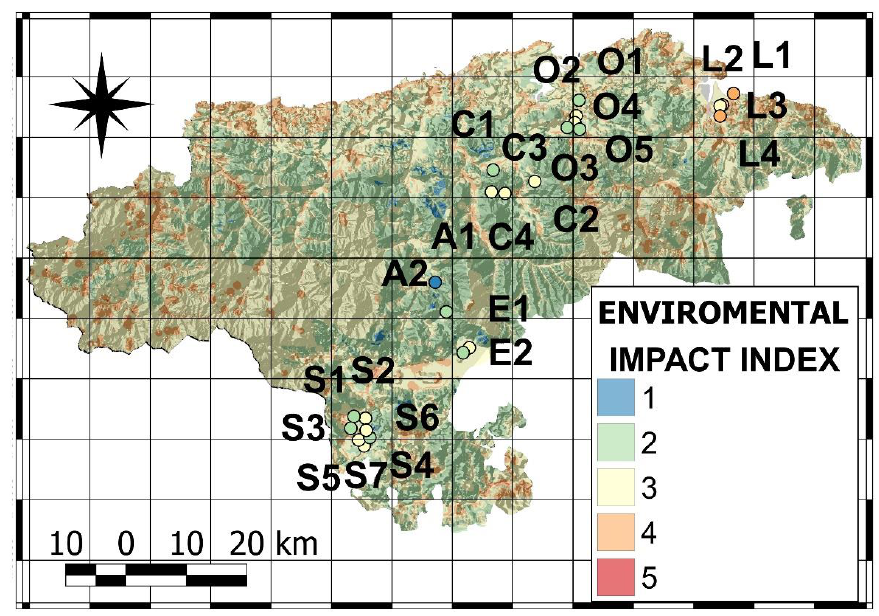
Figure 5. Map of reclassified environmental impact.